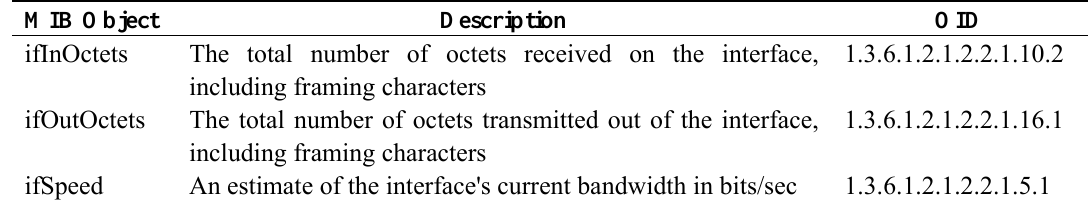
Table 1. MIB OIDs used in CNQF netmon class for bandwidth monitoring (RFC